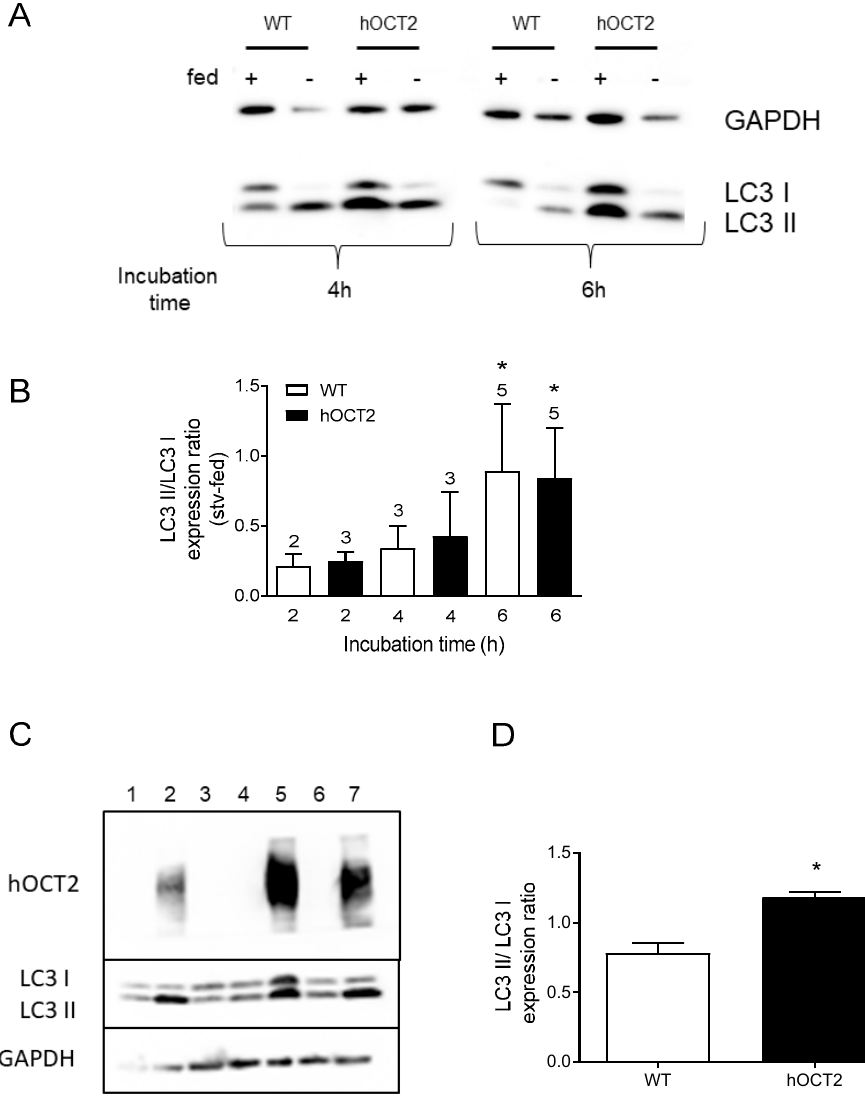
Figure 1. This figure shows the effects of starvation and of hOCT2 overexpression on cellular autophagy activity measured as LC3 II/I expression ratio in HEK293-WT (WT) and HEK293-hOCT2 (hOCT2) cells. Panel ( A ) shows a representative Western blot analysis of LC3 expression in cells incubated for 4 and 6 h in DMEM (fed +) or EBSS (fed − ) medium, as fed or starvation condition, respectively. GAPDH was used as a loading control. Panel ( B ) shows the quantification of Western blot analyses of lysates from WT (open bars) and hOCT2 (closed bars) cells. Data (mean ± SEM) are expressed as difference between LC3 II/LC3 I ratios determined at each time point for starvation and fed conditions in WT and hOCT2 cells, respectively. The numbers above the columns show the number of independent Western blot analysis performed. * shows that there is a statistically significant autophagy activation ( p < 0.05, comparison between starvation and fed conditions by paired t -test) after 6 h incubation both in WT and hOCT2 cells. Panel ( C ) shows the Western blot analysis of LC3 II/LC3 I expression ratio in WT (lanes 1, 3, 4, 6) and hOCT2 (lanes 2, 5, 7) cells with GAPDH as a loading control and hOCT2 signal as control for transporter expression. Panel ( D ) shows the quantification of the LC3 II/LC3 I expression ratio determined by Western blot analysis of lysates from WT (open column, N = 4) and hOCT2 (closed column, N = 3) cells. Data are given as mean ± SEM and * shows a statistically significant difference between WT and hOCT2 cells ( p < 0.05, unpaired t -test).